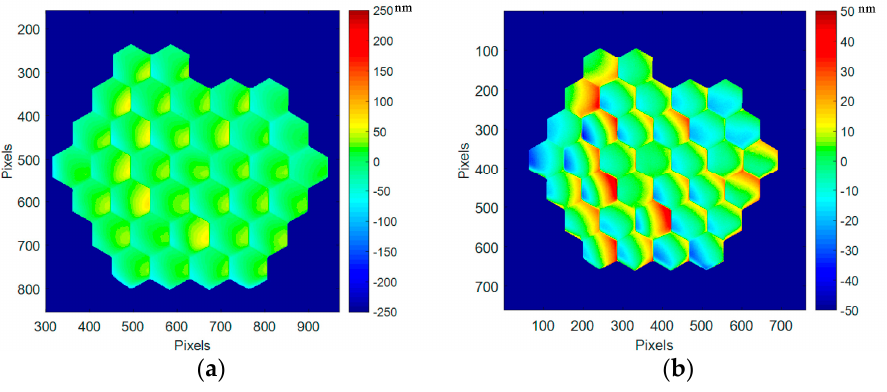
Figure 13. Mirror surface deformation at ambient (293 K) when best flat Iris AO condition is applied, after one cooling cycle: ( a ) Surface deformation map (22 nm RMS, 123 nm PtV); ( b ) Difference between the two surface deformation maps before and after one cooling cycle.